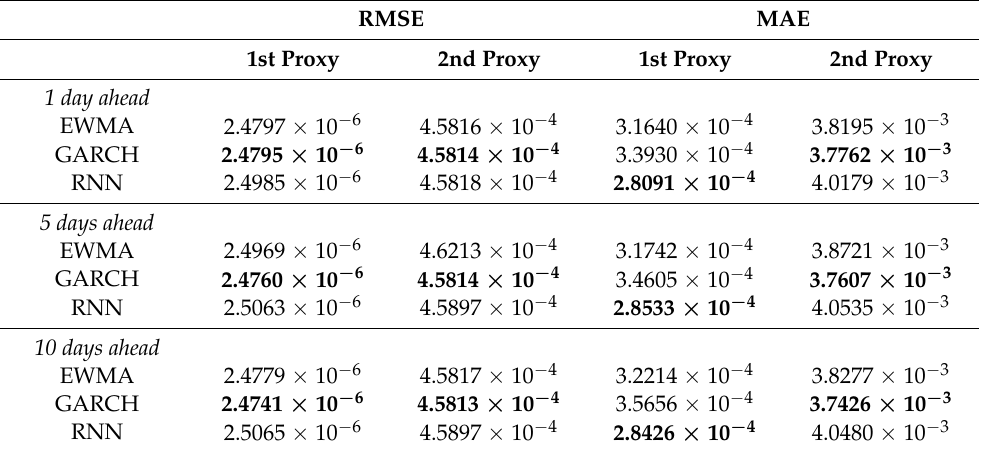
Table 5. Out-of-sample